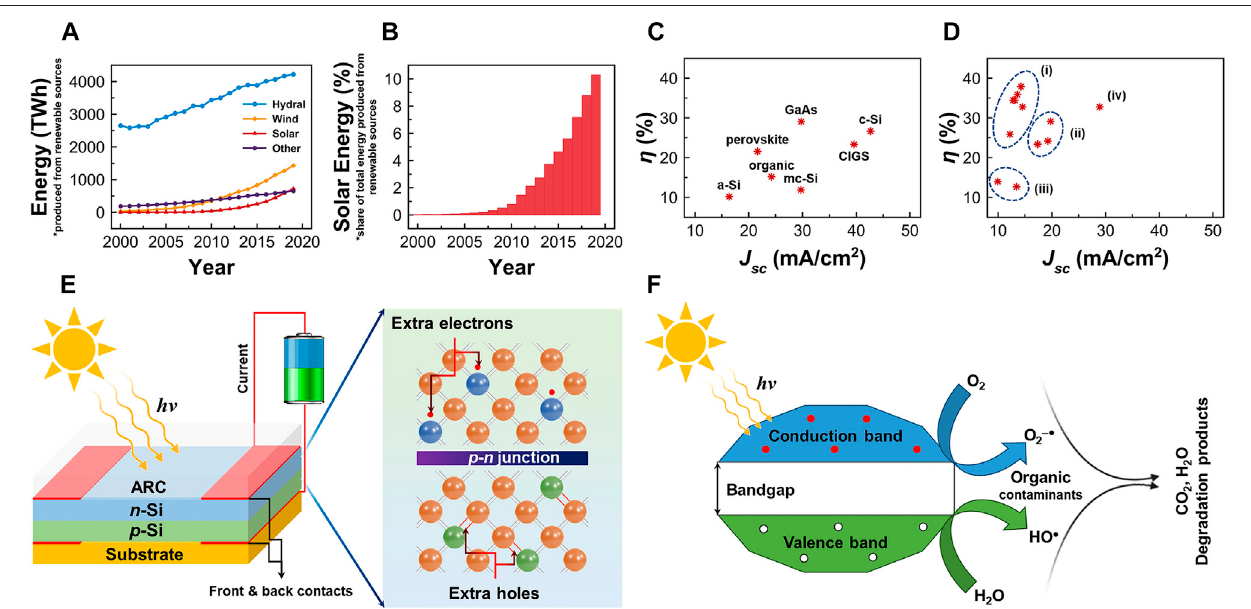
FIGURE 1 | (A) Total worldwide energy production from renewable sources, i.e., hydropower, wind, solar, and others including biofuels and biomass, etc., in the lasttwodecades;dataobtainedfromRitchieandRoser(2020). (B) Theshare(%)ofsolarenergyamongtotalenergyproducedfromrenewablesourcesoverthelasttwo decades;dataobtainedfromRitchieandRoser(2020). (C) Con fi rmedincidentphoton-to-currentconversionef fi ciency(IPCE, η (%))andshort-circuitcurrentdensity( J sc (mA/cm 2 ))ofsingle-junctionterrestrial solarcellbasedondifferentmaterials,dataobtainedfromGreenetal.(2021). (D) Con fi rmedIPCE( η (%))and J sc (mA/cm 2 )of multi-junctionterrestrialsolarcellbasedondifferentmaterials,i)GaInP-basedmulti-junctioncells;ii)c-SimultijunctionsolarcellswithperovskiteandGaAsP;iii)a-Si/nc-Si basedmulti-junctioncells;andiv)mechanically-stackedGaAs/c-Si,dataobtainedfromGreenetal.(2021).Abbreviations:a-Si,amorphoussilicon;c-Si,crystallinesilicon; CIGS, copper indium gallium selenide, Cu(In,Ga)Se; GaAs, gallium arsenide thin fi lm; mc-Si, multicrystalline silicon; nc-Si, nanocrystalline silicon. (E) A typical design of single p-n junctionsiliconsolarcell showingthe antire fl ective coating ontop. (F) Aschematic oftheself-cleaningprocess: themechanismofphotooxidative degradation of organic contaminants under sunlight irradiation. The charge carriers, i.e. pairs of electrons (e − ) and holes (h + ), are formed by the absorption of photons, which initiates the oxidative and reductive pathways at the conduction and valence bands, respectively via further reactions with active oxygen species or hydrolysis and leads to the photocatalytic degradation of contaminants to mineralized